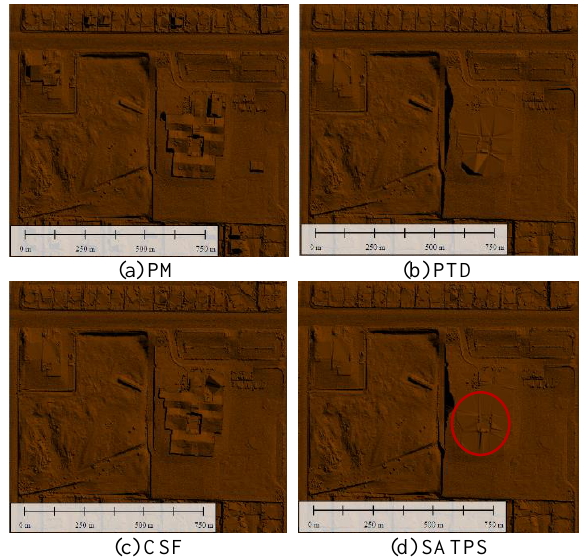
Figure 9. DEM generation of Area 10 using filtering results.